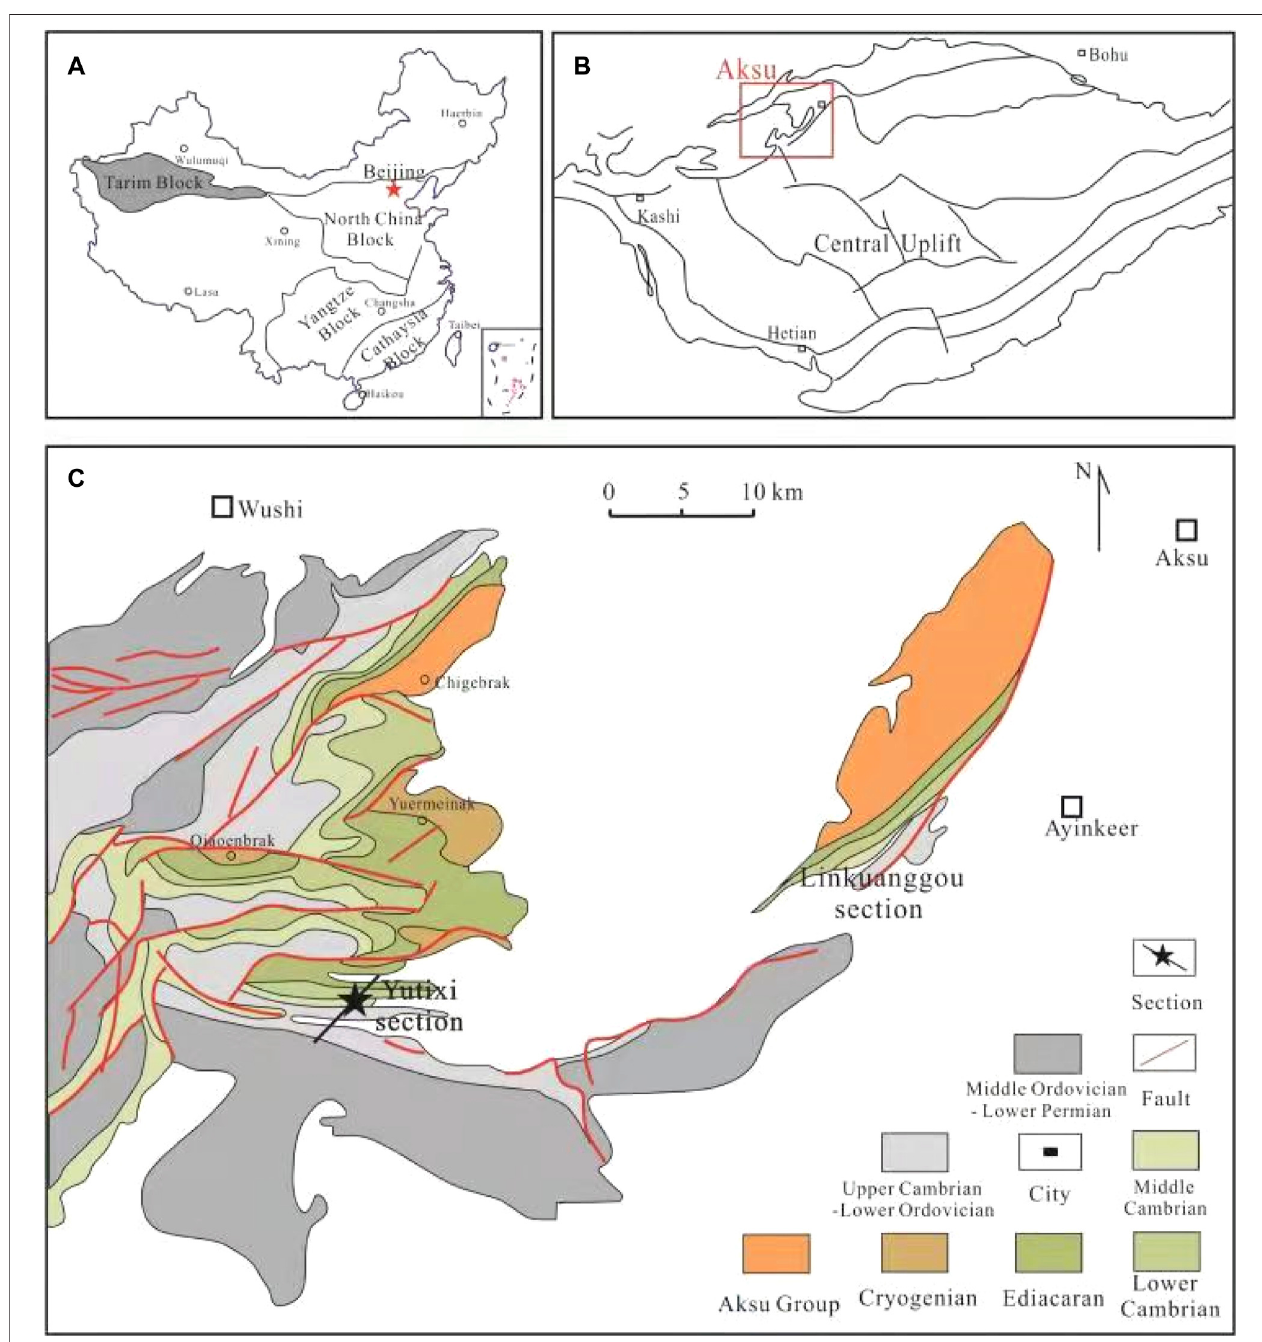
FIGURE 1 | (A) Geographic location of the Tarim Basin in northwestern China; (B) location map showing the tectonic units of the Tarim Basin and the Aksu area located in the northwest part of the Tarim Basin; (C) the fi eld pro fi le location of Aksu area, Tarim Basin (modi fi ed from Turner, 2010; Wen et al., 2015; Shen et al., 2022).